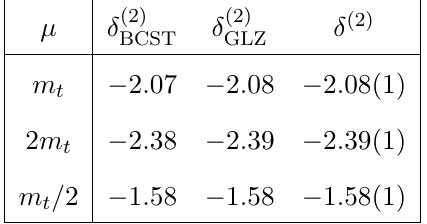
) and Blokland et al. [86] ( δ (2) GLZ BCST